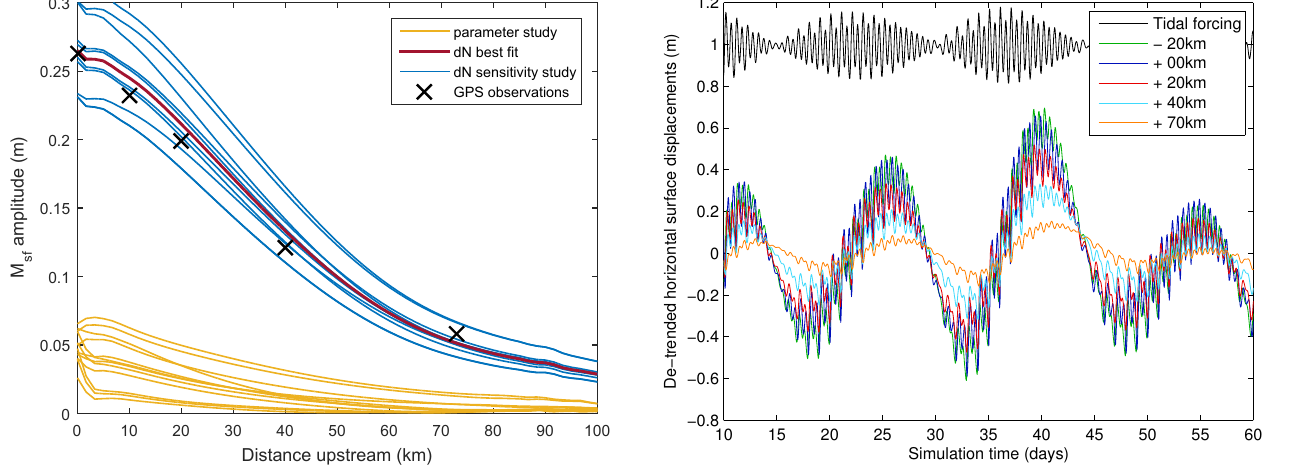
Figure 6. Modelled detrended horizontal surface displacements taken along the ice-stream medial line at 20km downstream ( − 20km), at the grounding line ( + 00km) and distances of 20, 40 and 70km upstream of the grounding line ( + 20, + 40 and + 70km, respectively). The model was forced with ¯ N =